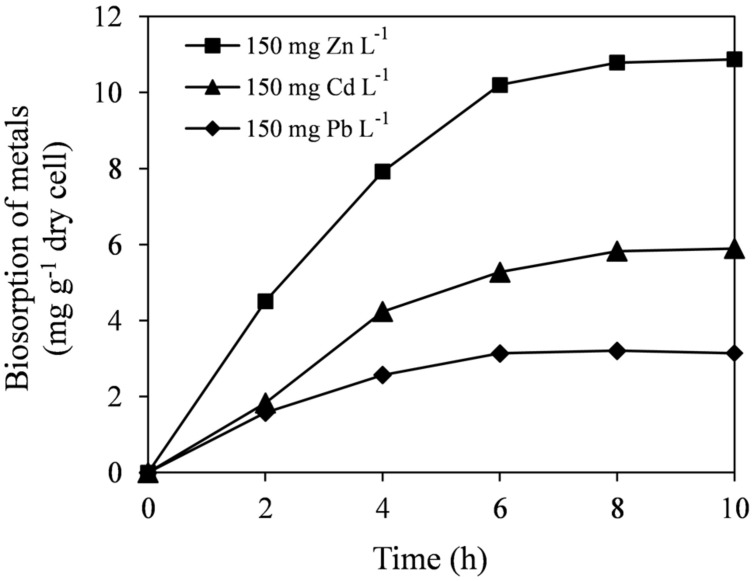
Biosorption of Cd, Zn, and Pb on E6S cells. Bars represent standard deviations of triplicates.